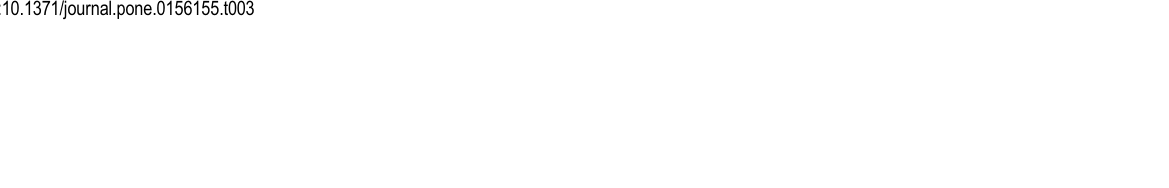
Abbreviations: AROC, area under the curve of receiver operating characteristic curve; CI, con fi dence interval; PPV, positive predictive value; NPV, negative predictive value; N/A, not applicable Risk scores other than the KRS were arranged in order of the higher AROC value. The performance of different risk scores for the prediction of incident diabetes was evaluated with each model ’ s original cutoff value and new cutoff value showing the highest Youden index. The results in the upper row of each score are based on the new cutoff value with the highest Youden index. The results in the bottom row of each score are based on the original cutoff value. * P values for the comparison of ROC curves between the KRS and other scores were calculated using DeLong ’ s methods [31]. † The new cutoff and original cutoff were the same for Japanese scores and French